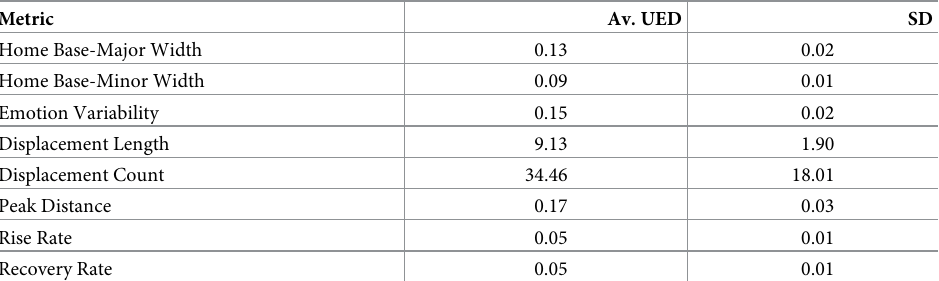
Table 2. Average UED metrics (2–6) and standard deviation (SD) in the v–a space for main characters in IMSDb ( N =